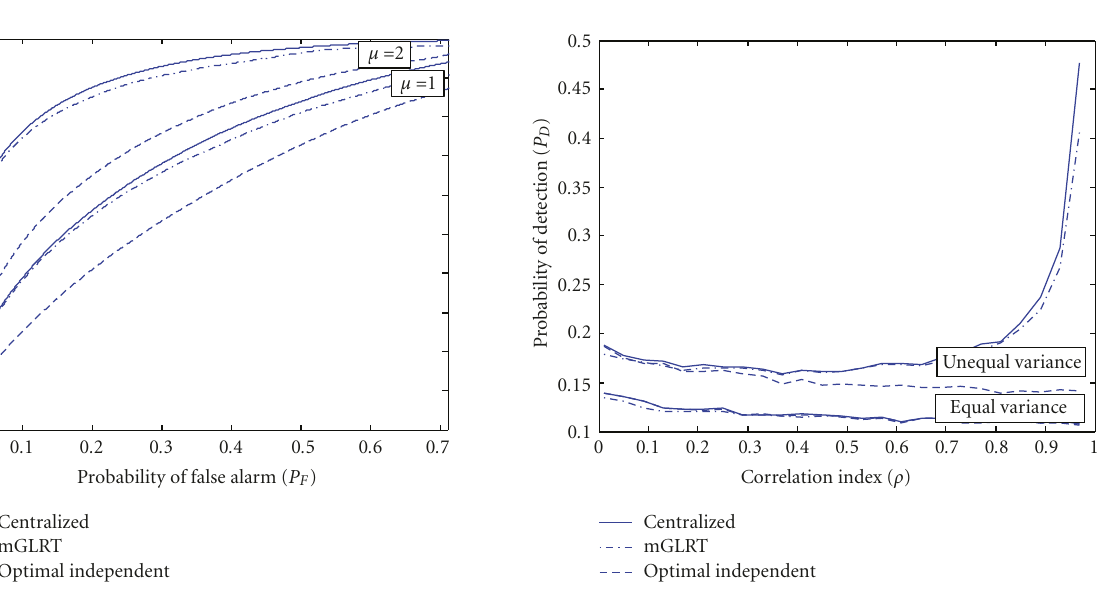
Figure 3: Performance of the mGLRT compared to the optimal independent test as the correlation index changes at P F = 0 . 05 with: σ 2 1 = 5, σ 2 2 = 2, κ i = 0 . 5 (unequal variance), σ 2 1 = 5, σ 2 2 = 5, κ i = 0 . 5 (equal